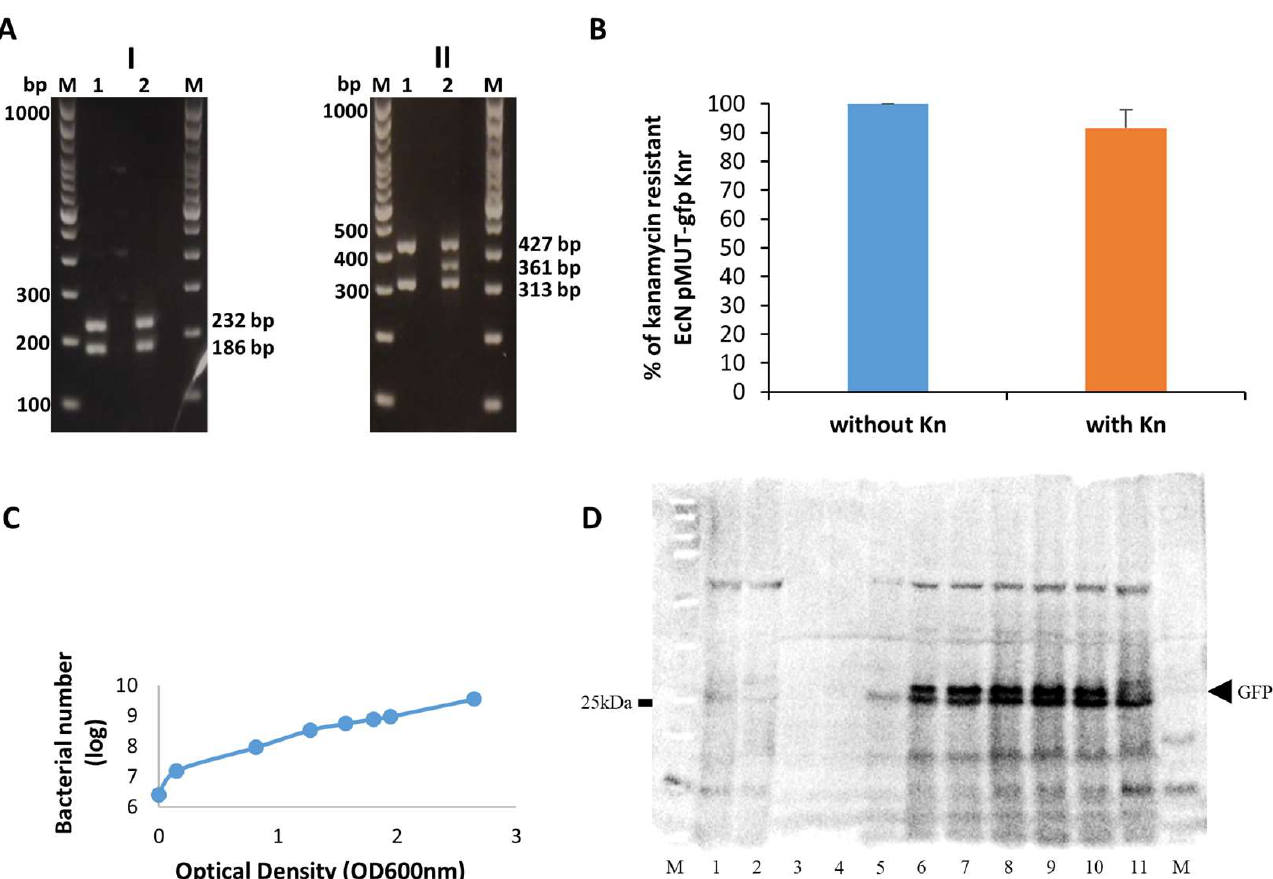
Figure 1. ( A ) PCR analysis of two different EcN strains. Chromosomal DNA specific (I) and plasmid specific (II) PCR analyses; Lanes: lane M: Marker (GeneRuler 100 bp DNA Ladder , Thermo Fisher Scientific, Germany, Cat. No. SM0321), lane 1: EcN/pMUT-gfp Kn r , lane 2: EcN (wild-type), ( B )